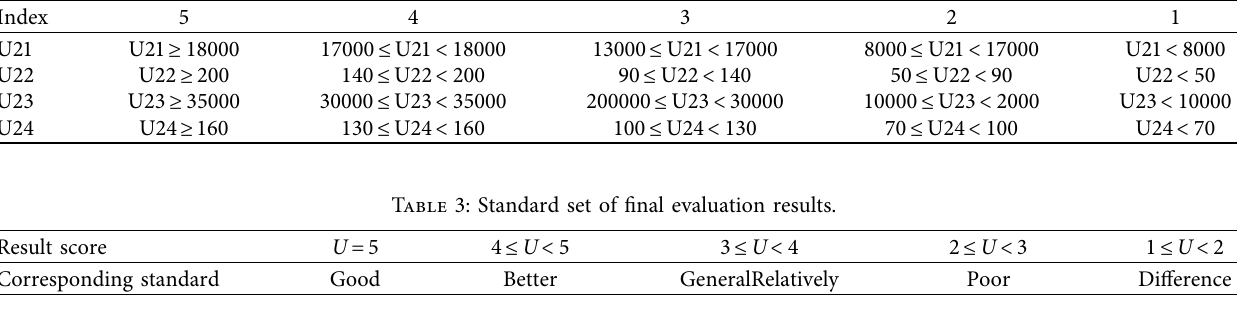
Table 4: Results of grade i evaluation of competitiveness of port city logistics function.